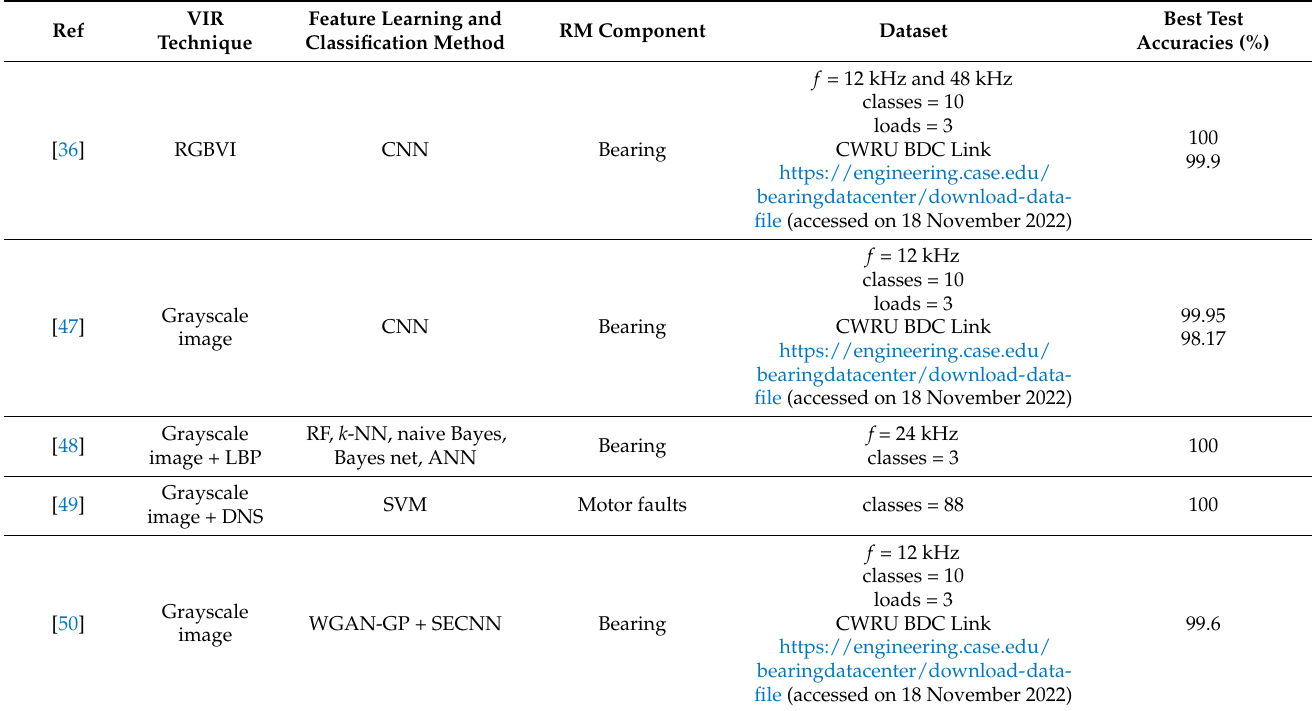
Table 1. Summary of the time domain vibration image representation techniques that are used in different studies of machine fault